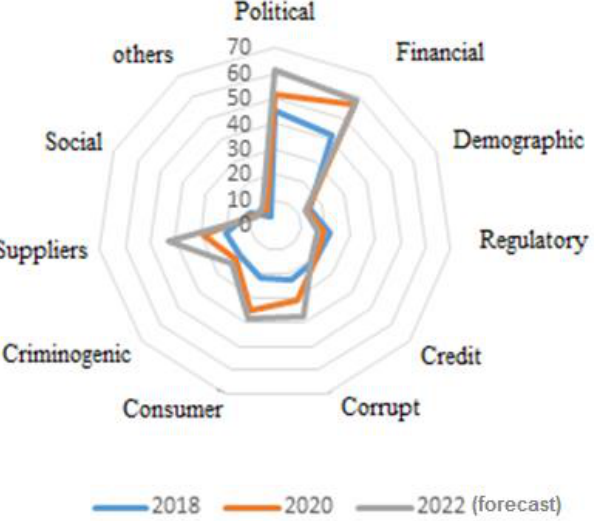
Figure 6. The results of the assessment of the group of intrastate risks of the enterprises of the cluster. Developed by Izmalkova I. and Leontyev